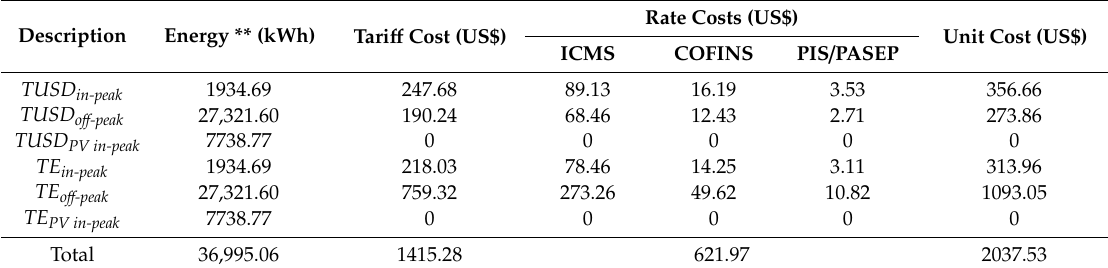
Table 9. Energy costs according to the White Tari ff for company B *.